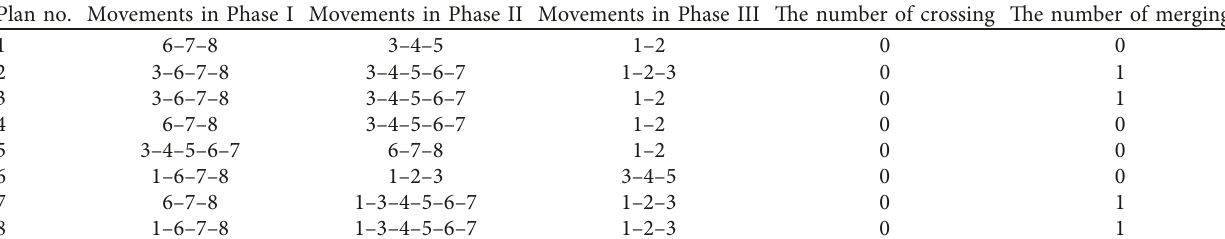
Figure 2: A three-leg signalized intersection model. Table 1: Designed possible phase plans and related